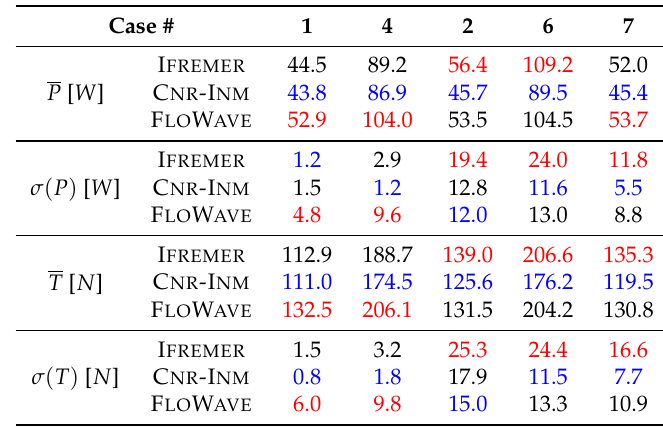
4. Numbers (cid:39)